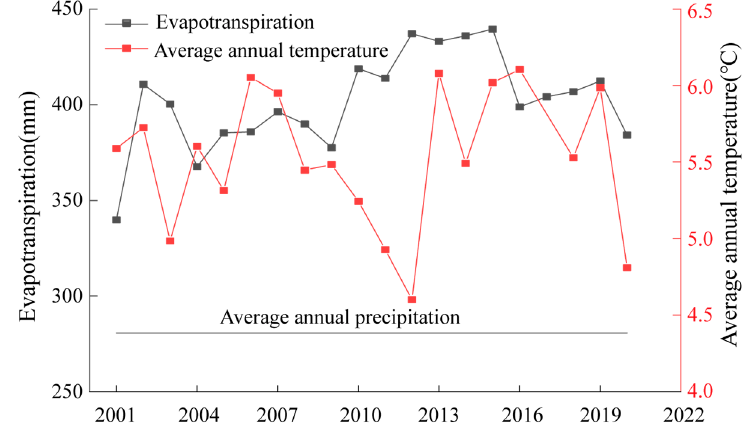
Figure 3. Meteorological data of northwest arid area from 2001 to 2020.